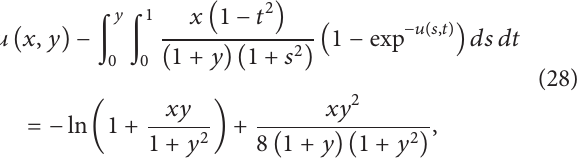
Table 4: Value of the root of mean square of residual errors that is computed by (29). The results for Examples 1, 2, and 3 are reported for Gaussian radial basis functions and 𝑁 = 400 . Comparison between Tables 1, 2, and 3 and following results confirms the strong correlation between absolute maximum of error and the root of mean square of residual errors. In brief, the estimation error of approximation is possible by (29) even as the exact solution is not